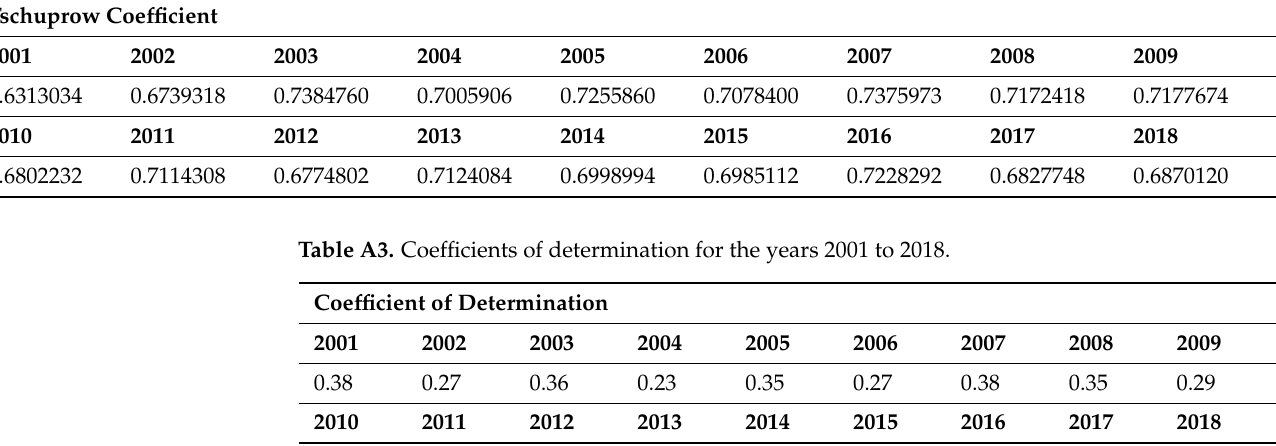
Table A2. Tschuprow coefficients 2001–2018.